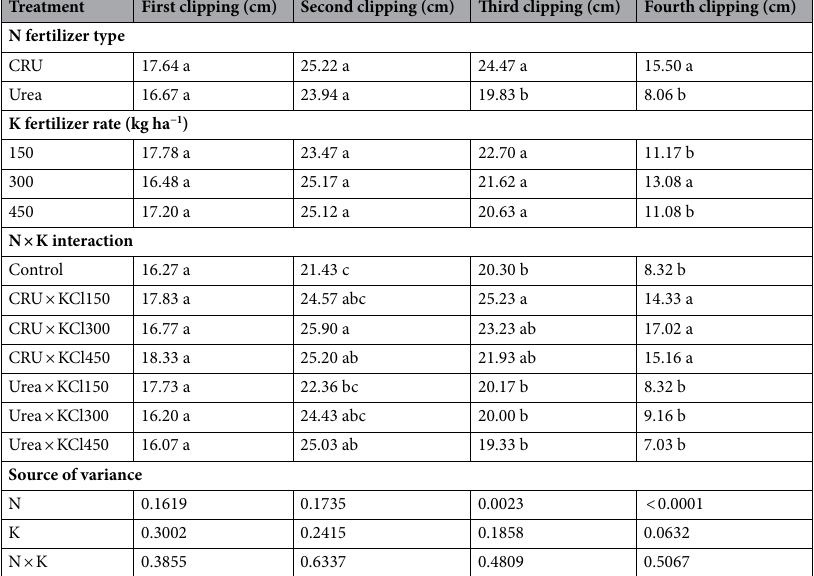
Similarly, the leaf area of Italian ryegrass in the whole growth period increased first and then decreased with the growth of the plant (Table 2). At the second clipping period, the apparent leaf area increased the fastest. The leaves of the plants were long and thin, and there was no difference between the fertilization treatments at the first and second clipping stages, but fertilization was more suitable to its growth; in addition, the leaf area of the